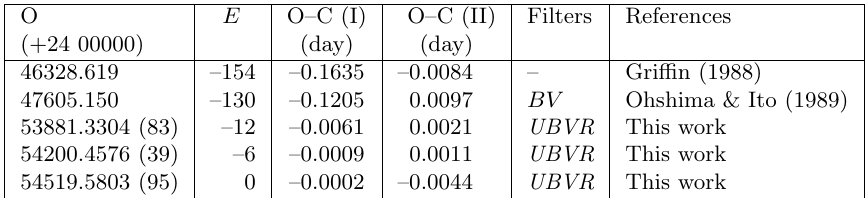
Table 1: The observed times of minima, their O–C (I) and the differences from the linear fit, O–C